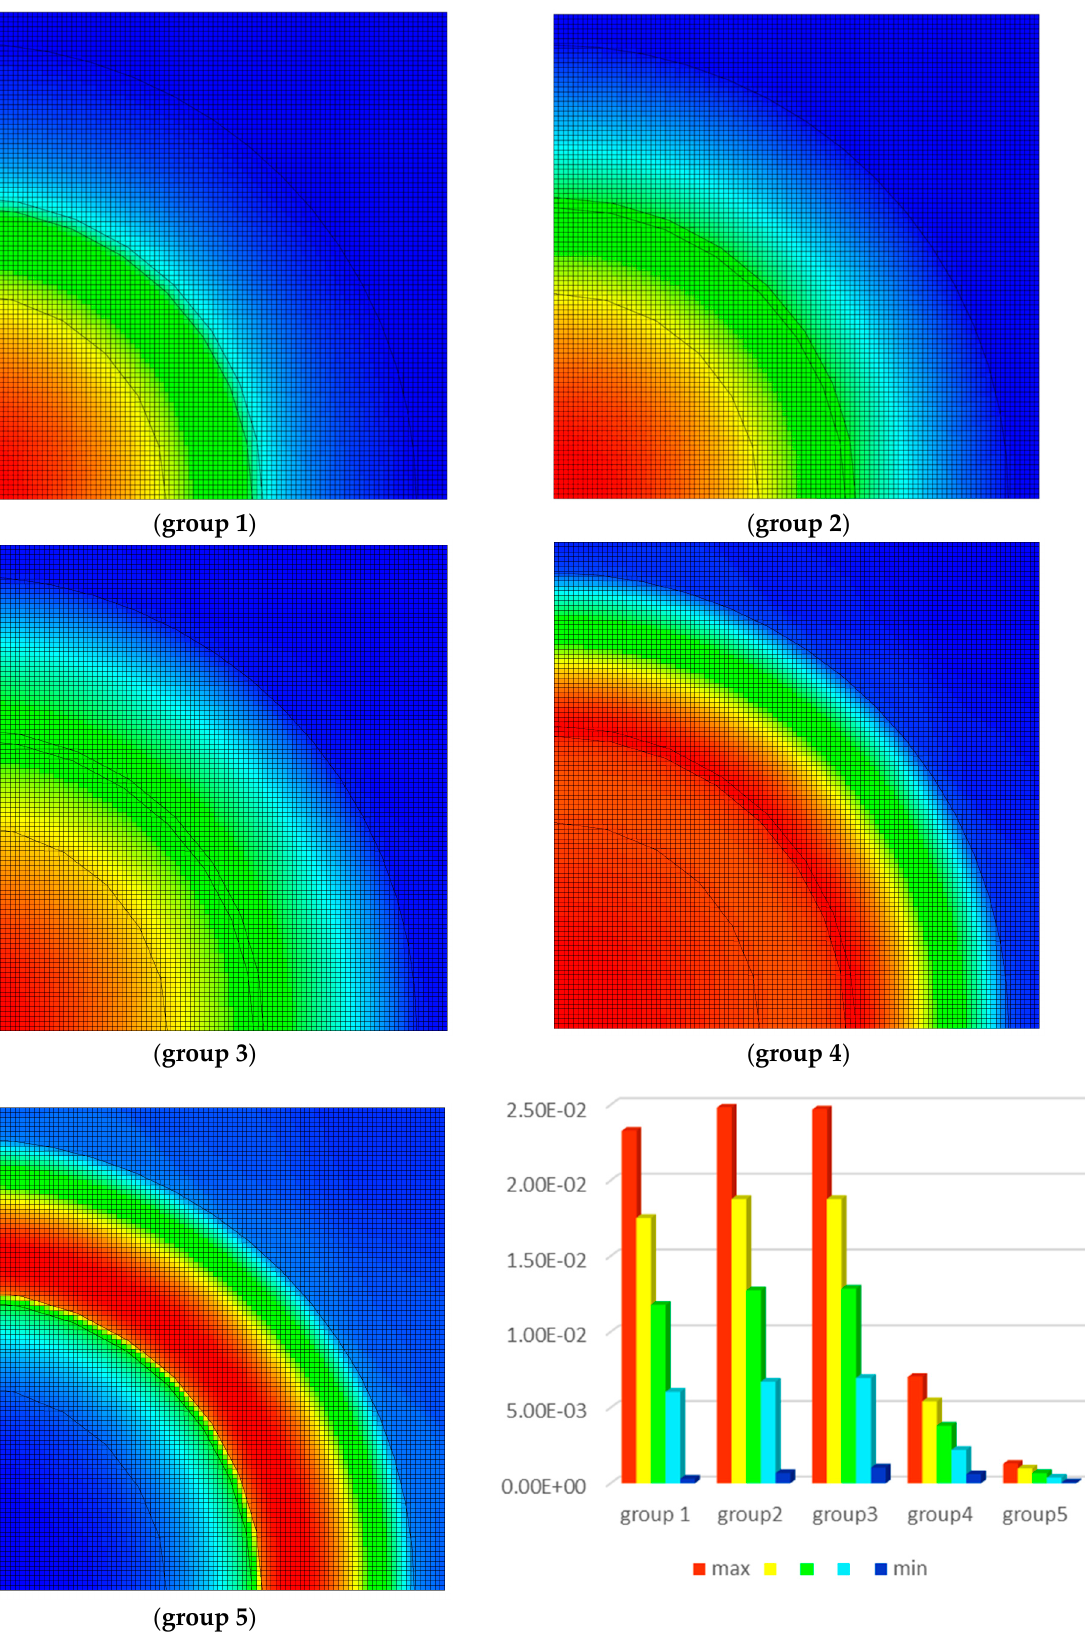
Figure 13. Spatial neutron flux distribution in the 5 energy groups defined in Figure 12 and related neutron flux values in each group with the colour map given in the bottom right figure (calculated using a TRITON-NEWT